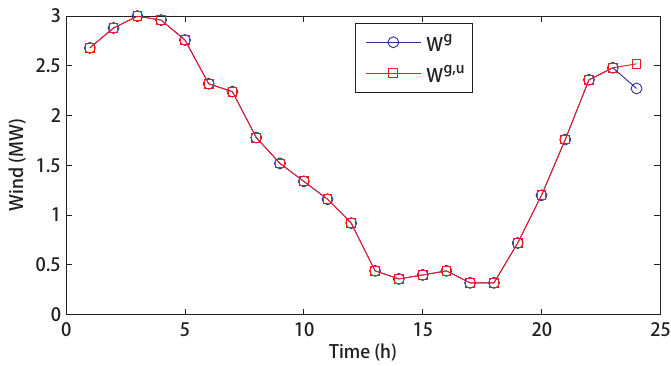
Figure 8. Renewable energy consumption and